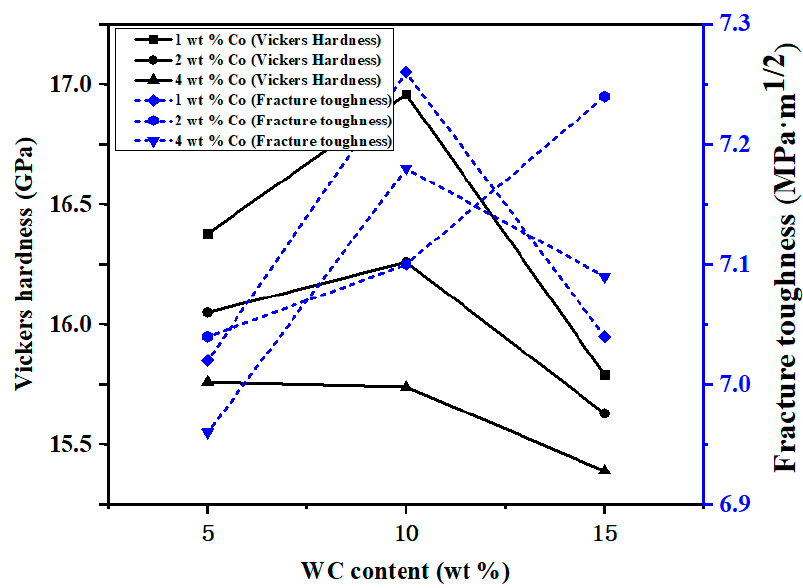
Figure 2. Vickers hardness and fracture toughness of the Si 3 N 4 /WC ceramic tool at different Co content and WC content.